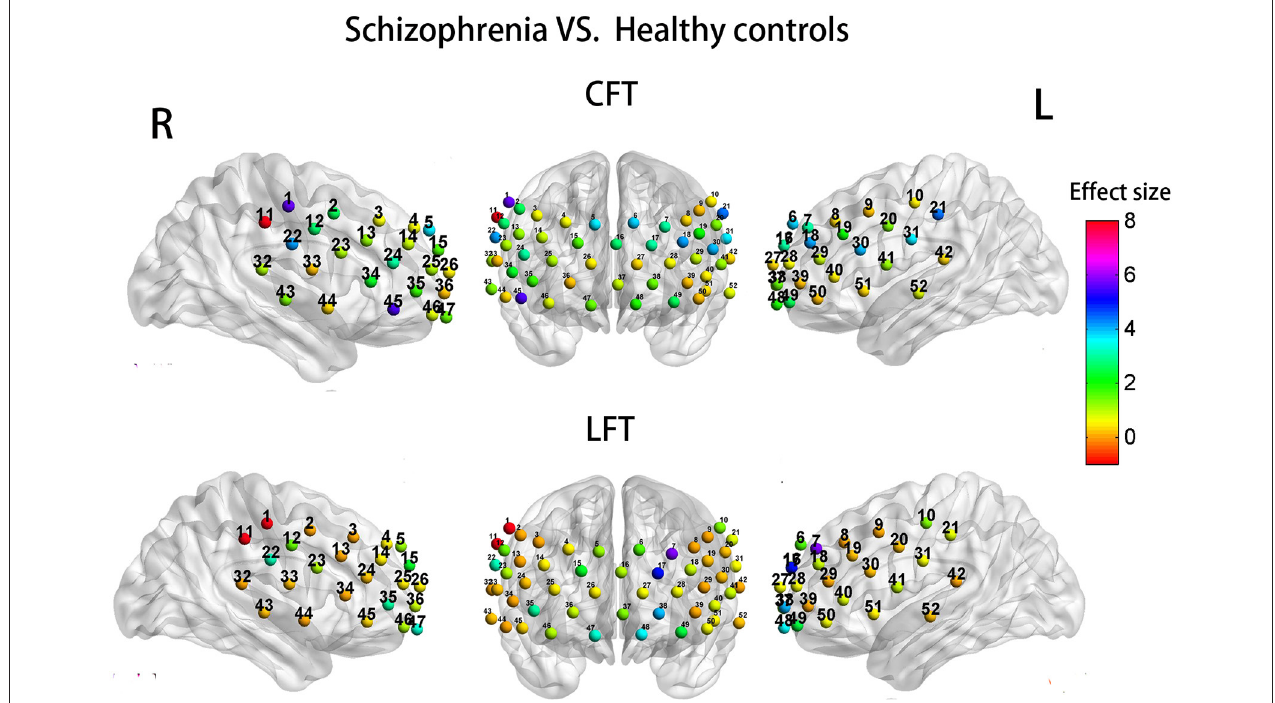
FIGURE 5 | Group differences in task-related cortical activation during the CFT (upper) and LFT (lower) .